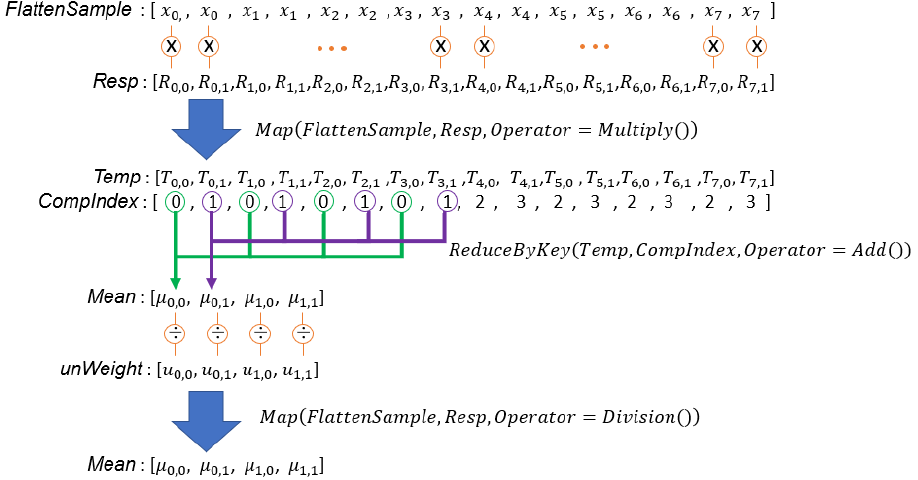
Figure 8. The computation process of Mean . R i , j is a responsibility computed from the i th sample and j th Gaussian component. µ i , j is the mean vector of the j th Gaussian component in the i th